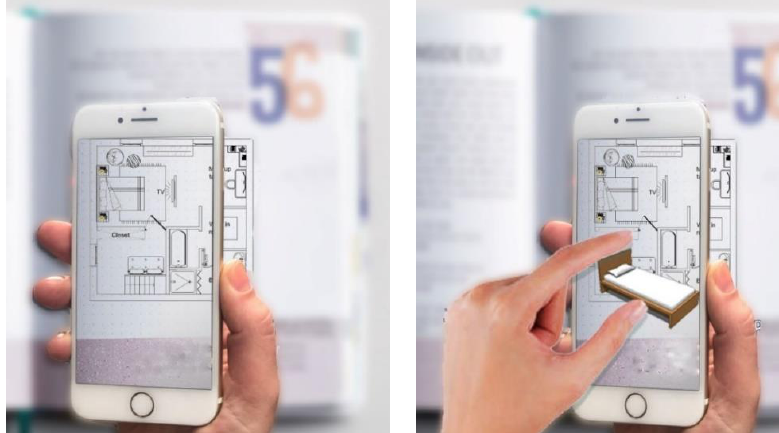
Figure 1. Overview of our mobile augmented reality (MAR)-based teaching tool to support students in the learning process of interior design.